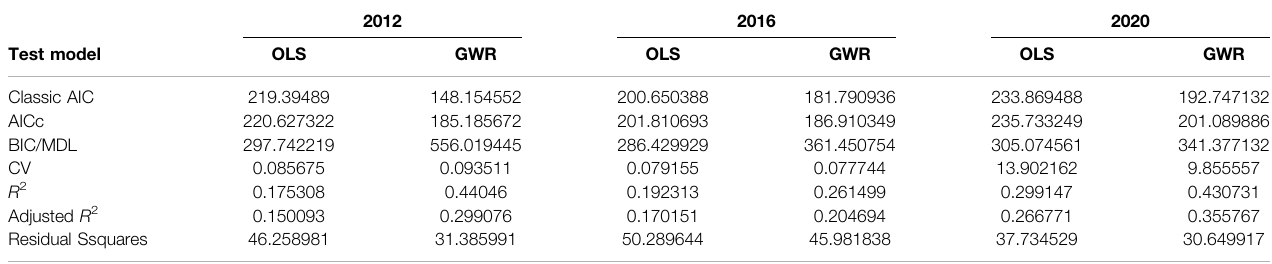
TABLE 5 | Comparison test parameters of OLS model and GWR model for 2012, 2016, 2020.